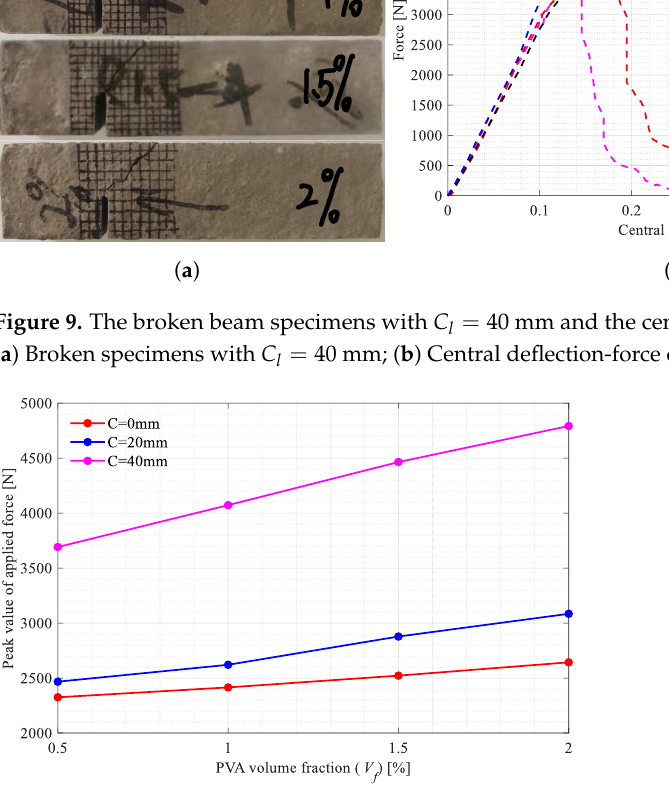
Figure 10. Variations in the peak force values in the tests versus the volume fractions of PVA fibers in the